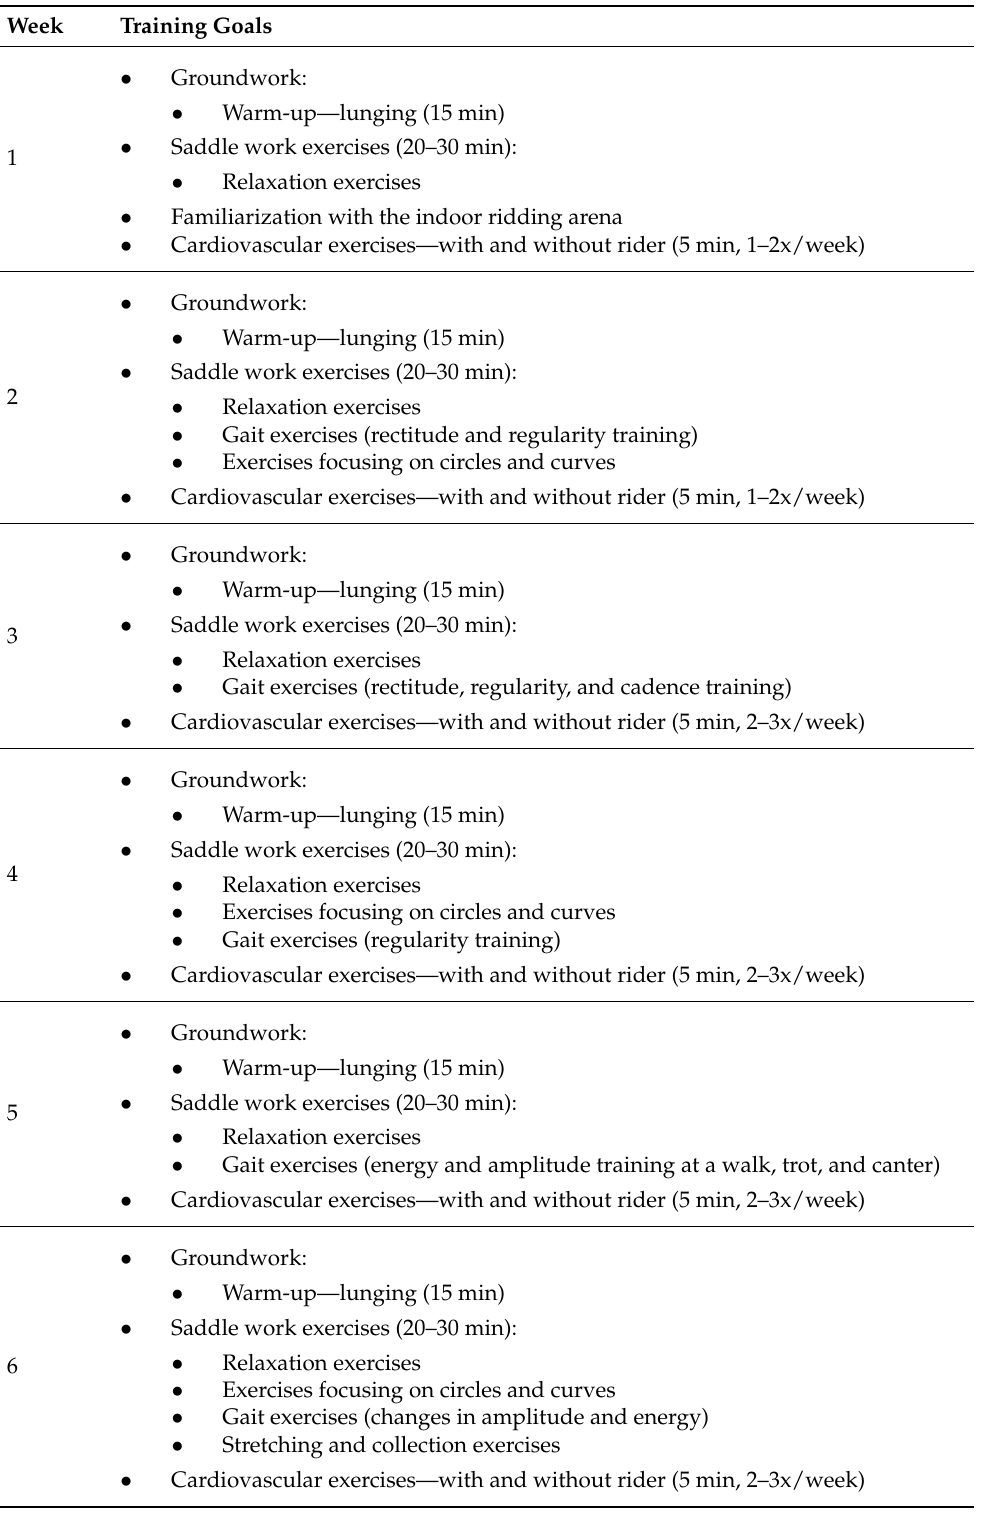
Table 1. Training schedule for the young Lusitano